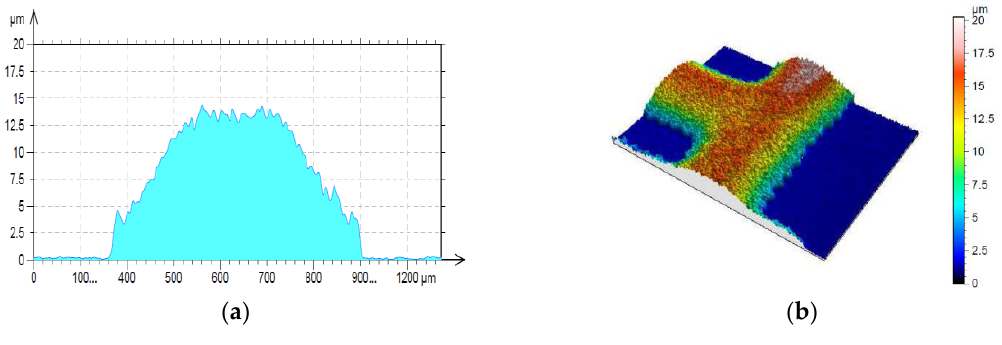
Figure 8. Profile of antenna elements and routes of electronic circuits: ( a ) cross-section; ( b ) surface topography.